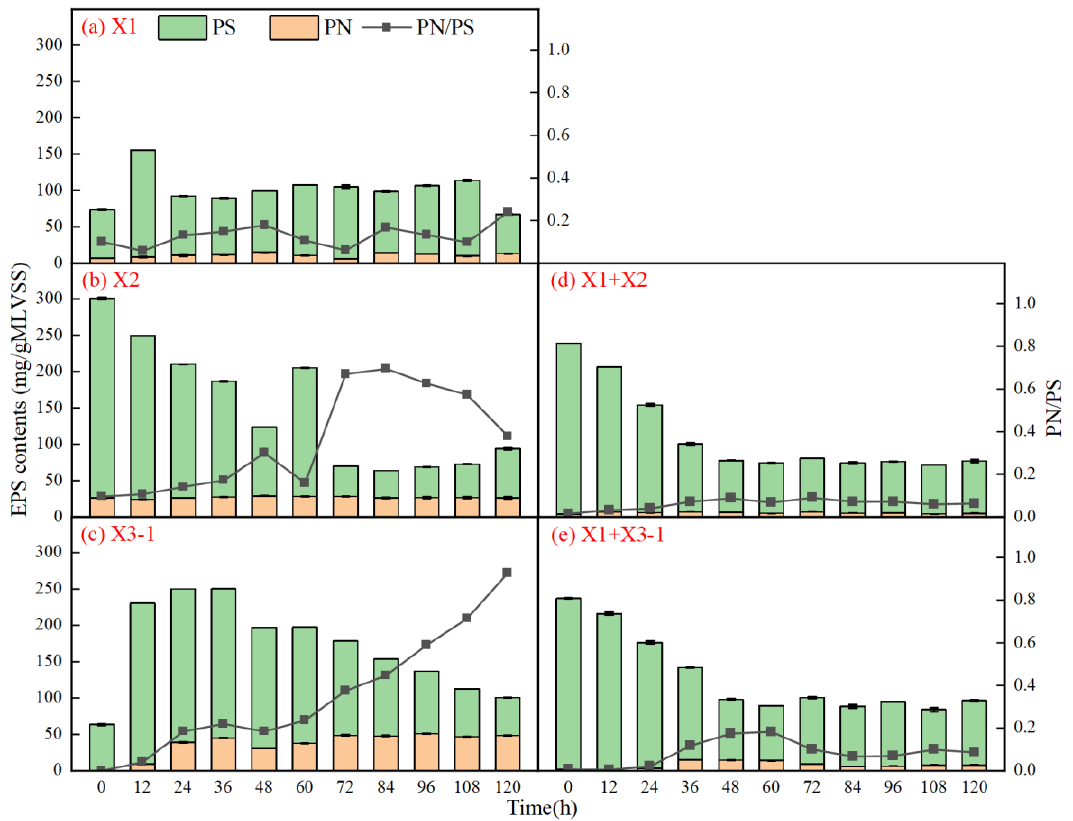
Figure 2. PS, PN and PN/PS of X1( a ), X2( b ), X3-1 ( c ), X1 + X2 ( d ) and X1 + X3-1 ( e